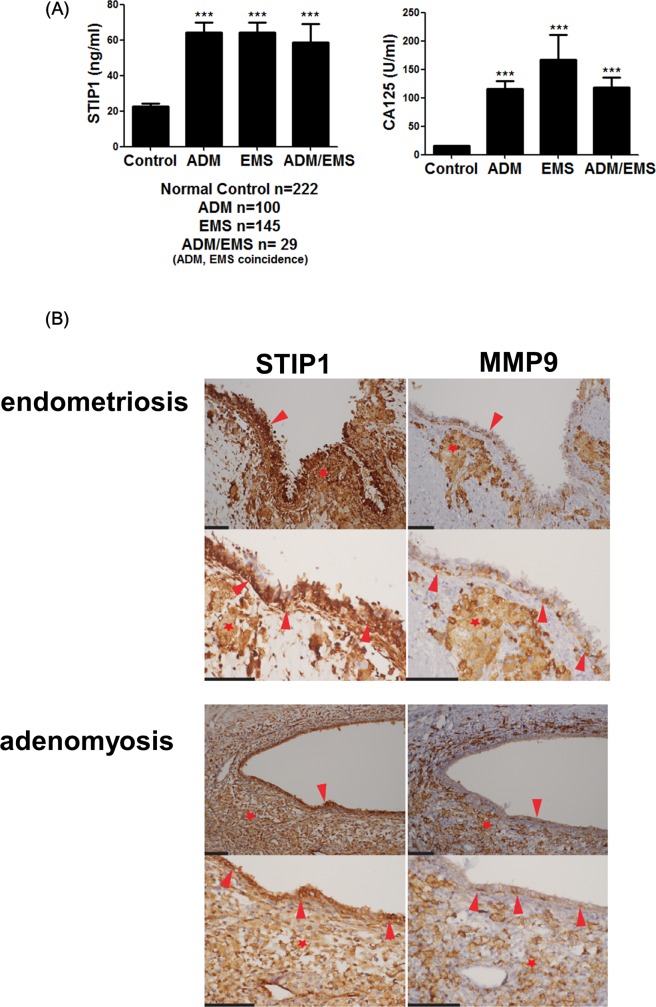
STIP1 overexpression in endometriosis/adenomyosis.(A) Serum levels of STIP1 (left panel) and CA125 (right panel) were significantly higher in patients with endometriosis (EMS), adenomyosis (ADM), or coexisting endometriosis and adenomyosis (EMS/ADM) than in the age-matched controls. Statistical differences were calculated with Student’s t-test. *p < 0.05 and **p < 0.01. (B) Photomicrographs of immunohistochemical staining for STIP1 and MMP9 in a representative case of ovarian endometriosis and uterine adenomyosis taken with a 20× objective (upper panels) and 40× objective (lower panels) lens. Both ectopic endometrial epithelia (arrowheads) and stroma (stars) showed cytoplasmic expressions of STIP1 and MMP9, in both endometriosis and adenomyosis. Scale bars represent 100 μm. Abbreviations: EMS, endometriosis; ADM, adenomyosis.